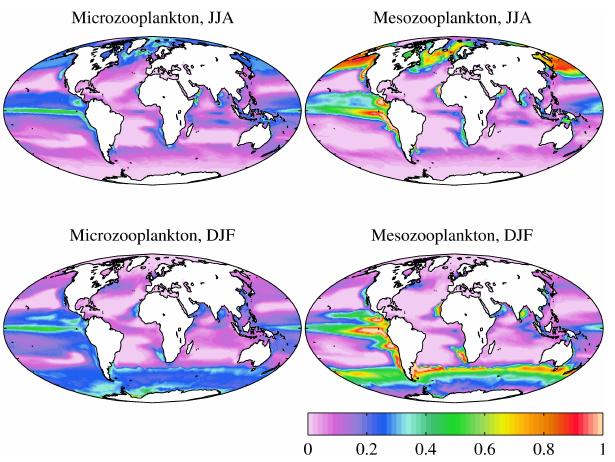
37 Fig. 27. Simulated diatom biogenic opal ( left ) and calcium carbonate ( right ) production for northern summer (June–July–August; top ) and northern winter (December–January–February; bottom ). Biogenic opal production in